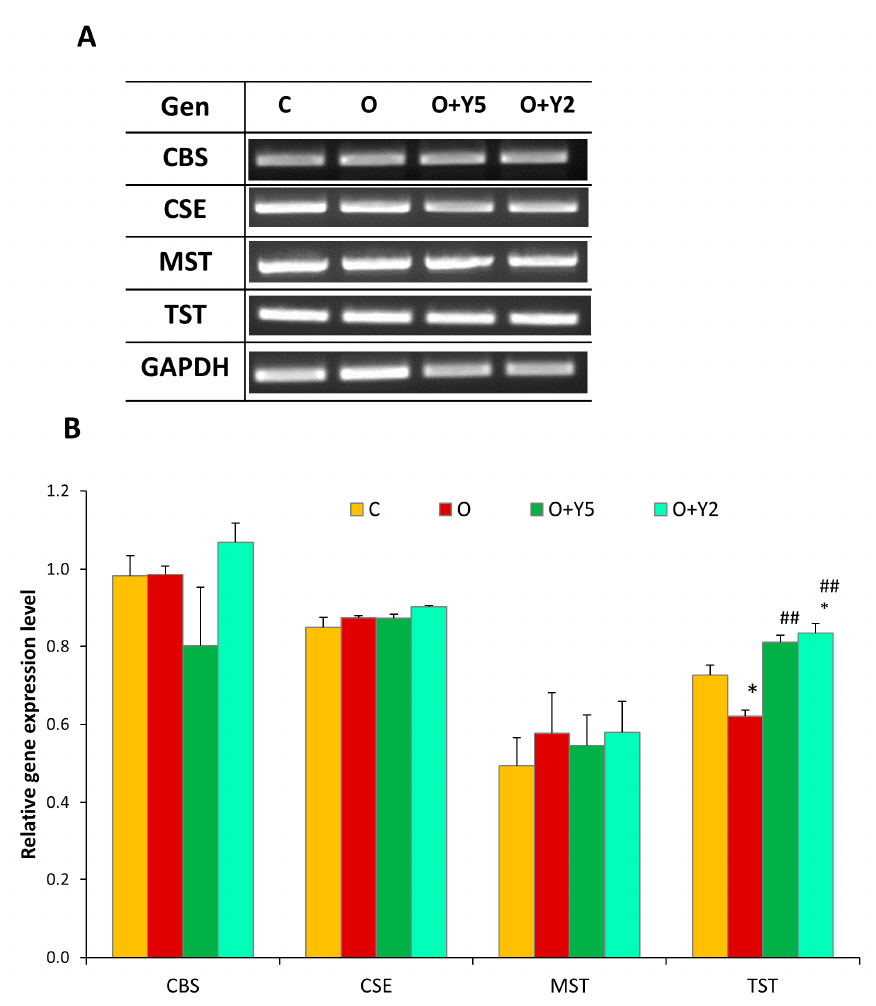
Figure 5. RT-PCR analysis. ( A ) Gene expression in the liver of rats. The results are representative and were chosen from 3 tests. ( B ) The relative expression level of CBS, CSE, MST, and TST in the livers of rats. Densities of bands were normalized using the signal for the GAPDH gene. C—control rats fed a standard diet; O—rats fed with HFD; O + Y5—rats fed with HFD and treated intraperitoneally (i.p.) with yohimbine at a dose of 5 mg/kg/day for 30 days; O + Y2—rats fed with HFD and treated intraperitoneally (i.p.) with yohimbine at a dose of 2 mg/kg/day. Data are presented as the mean ± SEM, n = 3 per group. Statistical analysis was performed using a one-way ANOVA; symbols indicate significance of differences according to the Tukey post hoc test, * p < 0.05 vs. group C; ## p < 0.01 vs. group O.